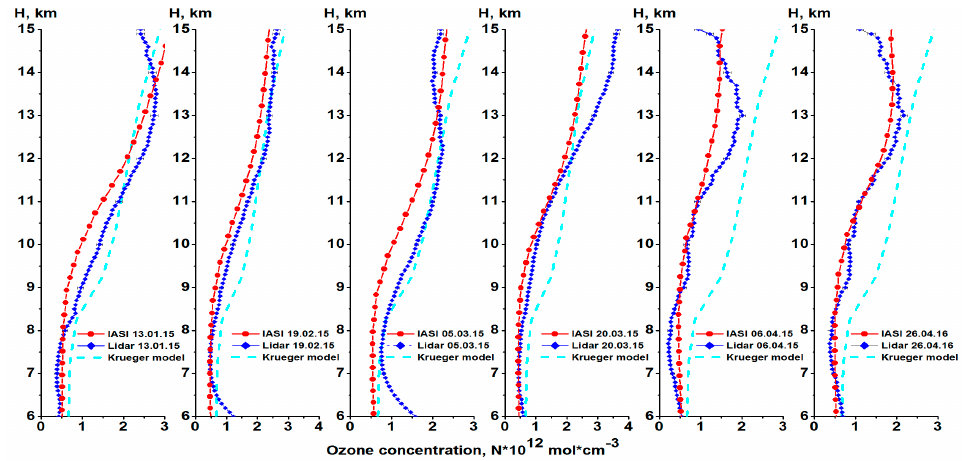
Figure 6. Intercomparison of vertical profiles of ozone for 2015.